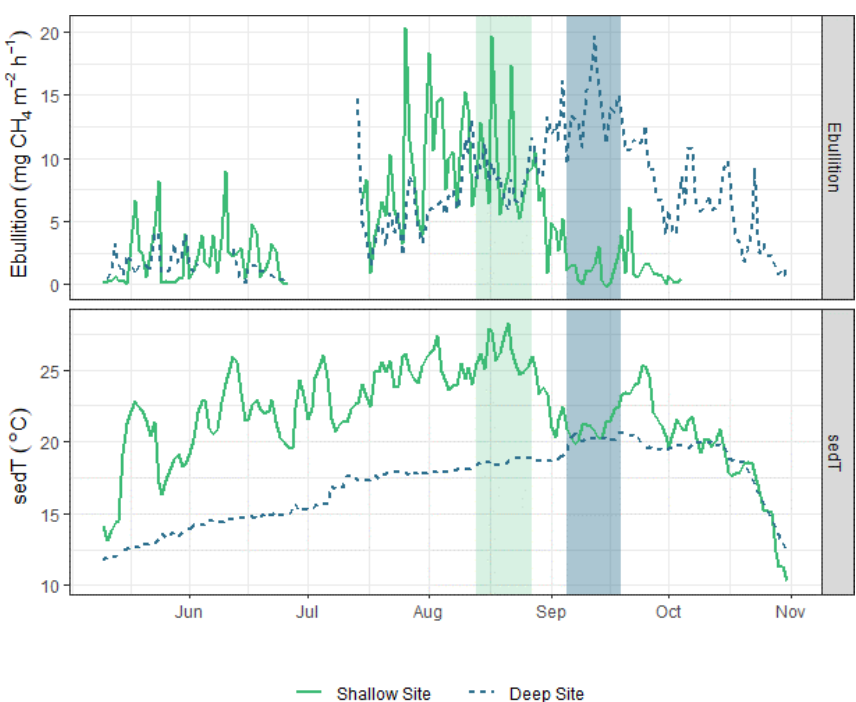
Figure 8. Time series of sedT and ebullition in 2017 at the shallow (solid green line) and deep (dashed blue line) sites. The light grey bar highlights the period of maximum ebullition and sedT at the shallow site; the dark grey bar highlights the corresponding period at the deep site. Table 3. Summary statistics describing the relationship between F CH dimensional Kolmogorov–Smirnov test (2DKS) threshold